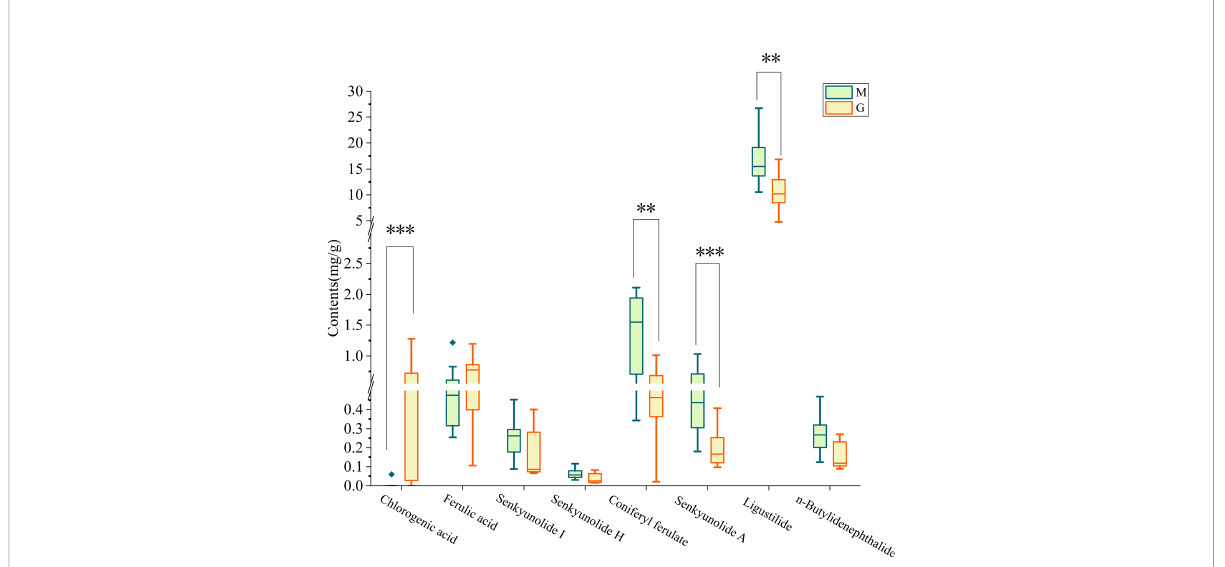
FIGURE 5 Comparison of the medicinal components of A. sinensis samples between group M and G. ** P ≤ 0.01; *** P ≤